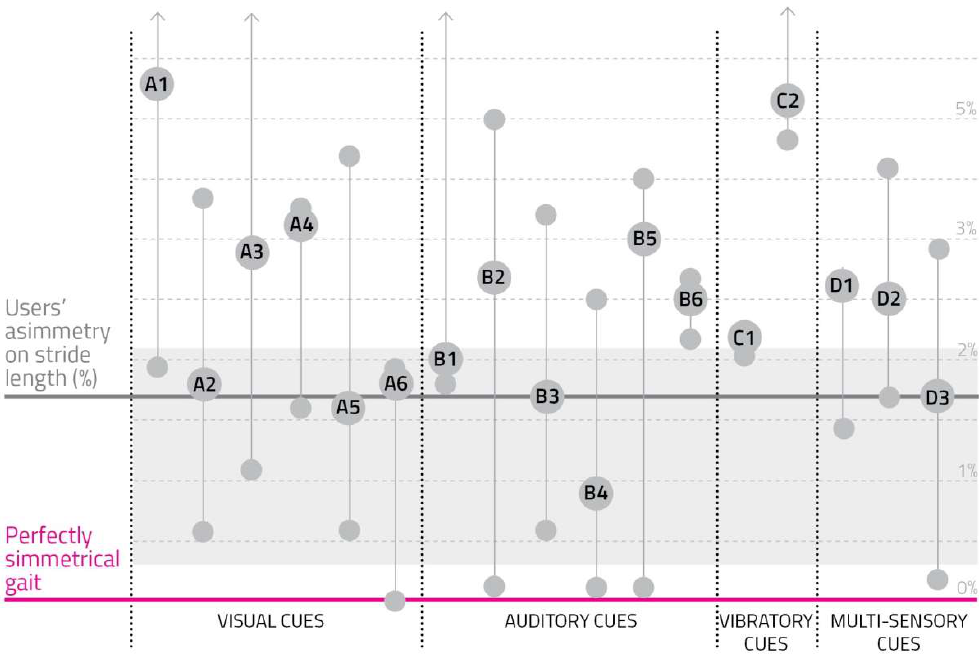
Figure 8. Users’ asymmetry index on stride length. The gray section represents the user’s typical asymmetry in stride length, while the pink line is a perfectly symmetrical gait. Every cue prototype corresponds to the vertical line connecting three circles: the one on the lower part of the line represents the user with the lower asymmetry; the second circle is bigger and shows the cue code, standing for the average user’s asymmetry in stride length; the upper small circle indicates the user with the most asymmetrical gait cadence.